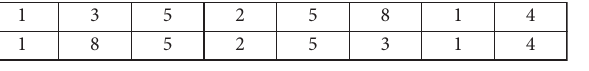
Figure 3: How mutation operator works.